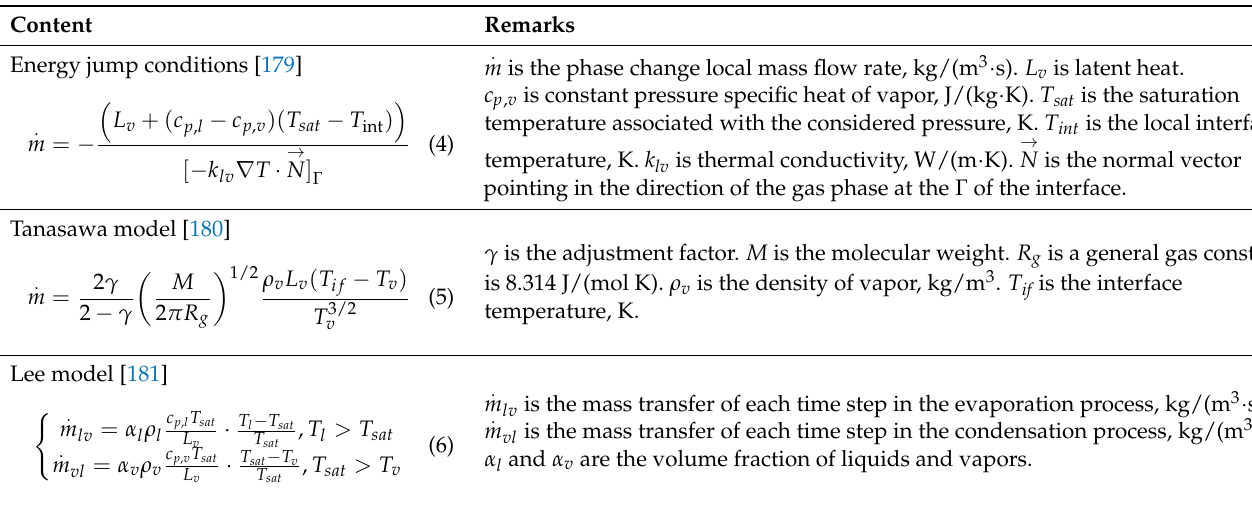
Table 4. Numerical model of interphase mass